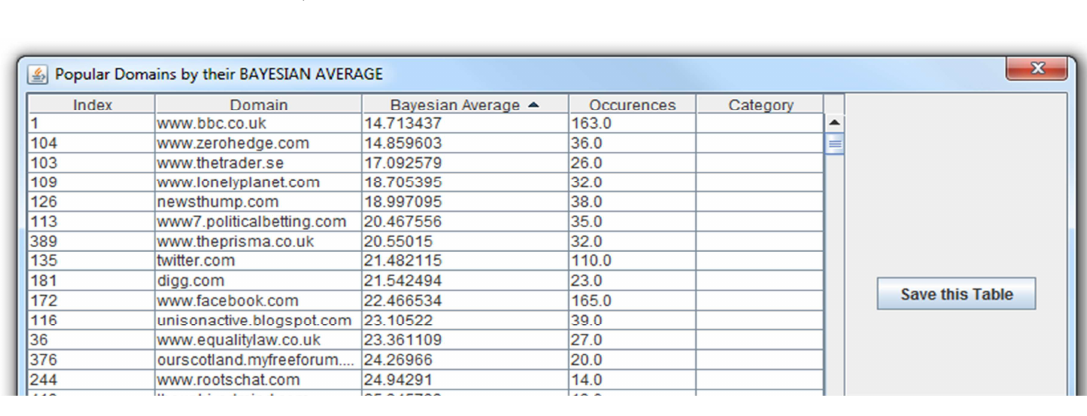
Figure 5: Bayesian Average Overall